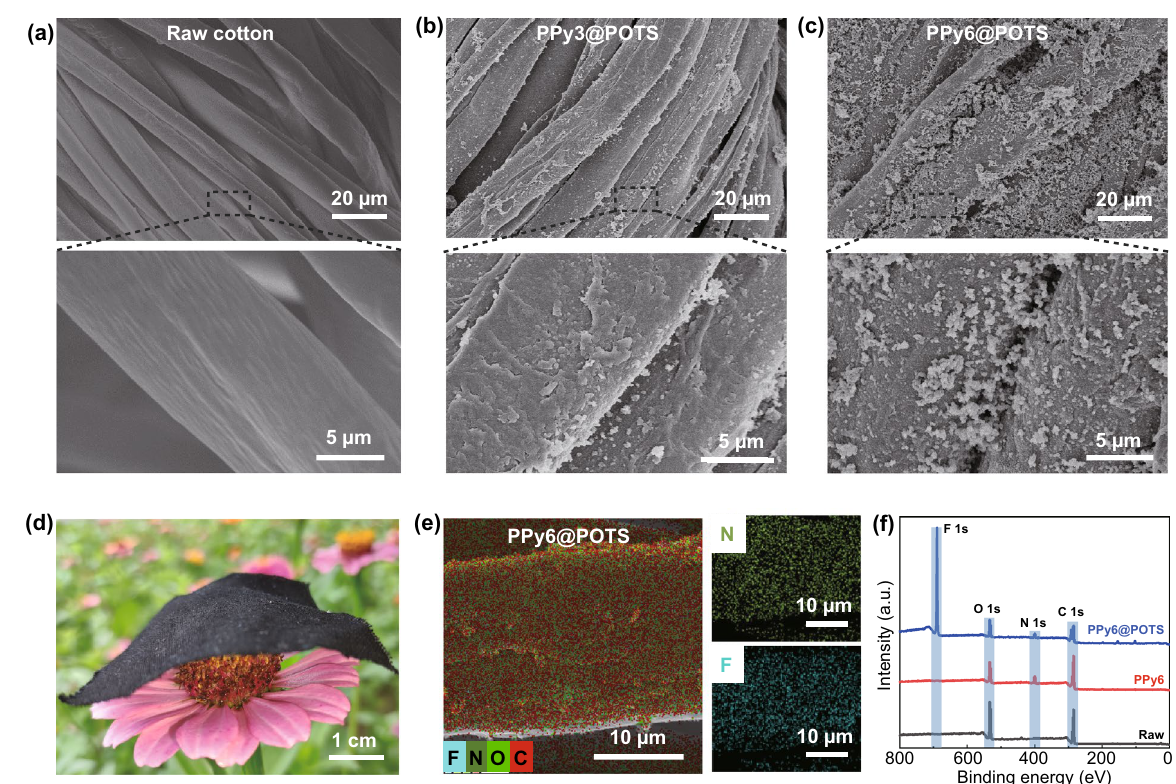
Fig. 2 Morphologies and elemental compositions of PPy n @POTS fabrics. a–c SEM images of a raw, b PPy3@POTS, and c PPy6@POTS fab- rics. d Photograph of a swatch of PPy6@POTS cotton fabric draped on a flower. e EDS elemental mapping of PPy6@POTS fabric, showing the uniform distribution of the PPy and POTS coatings. f XPS spectra of raw, PPy6 and PPy6@POTS